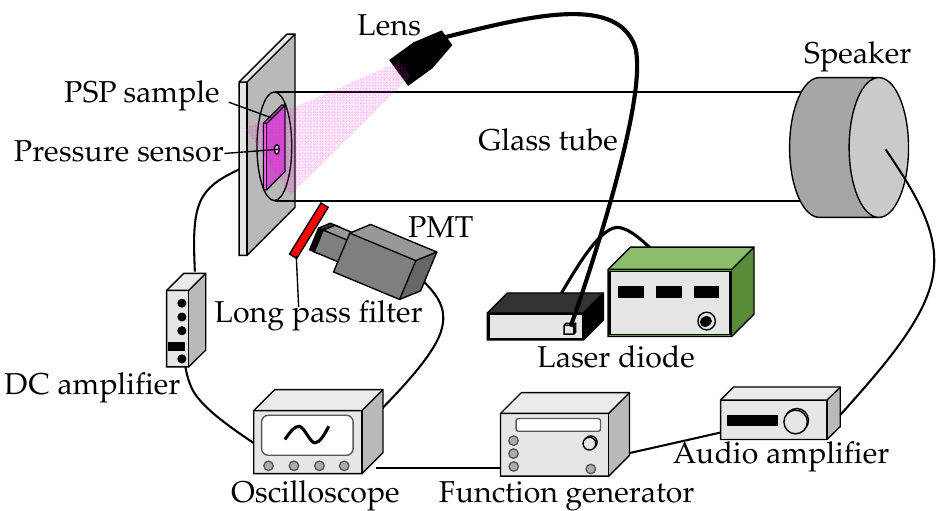
Figure 4. Schematic diagram of acoustic resonance tube.